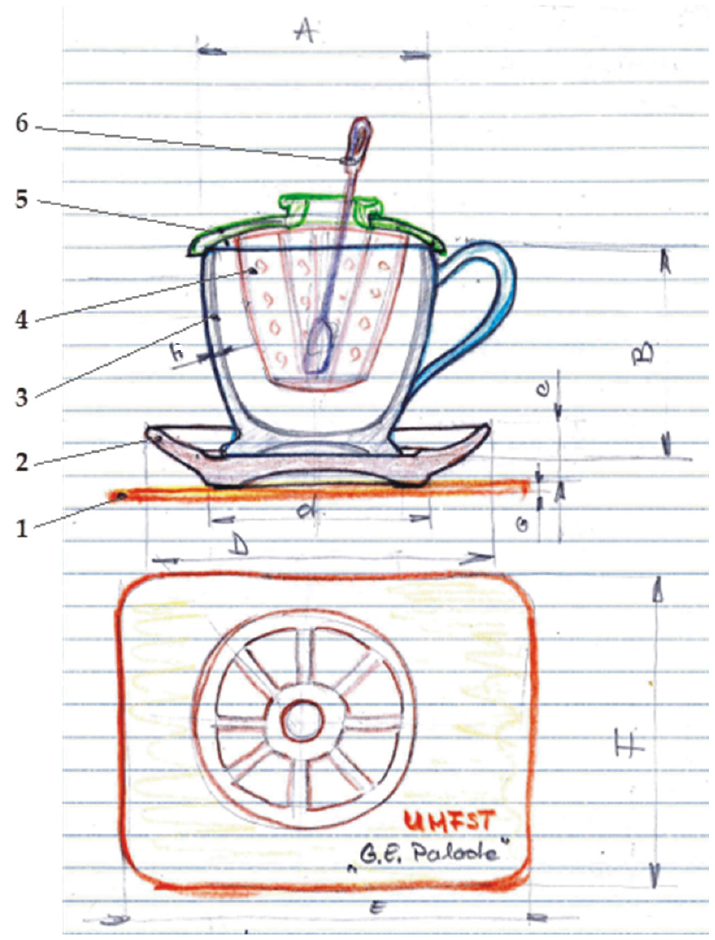
Figure 2. Sketch-proposal concept: set toy for children—teacup: (1) promo biscuit holder, (2) saucer, (3) teacup, (4) separator filter, (5) lid, (6) stirring spatula, A,B,C,D,E, G, c,d,h-geometric dimension .